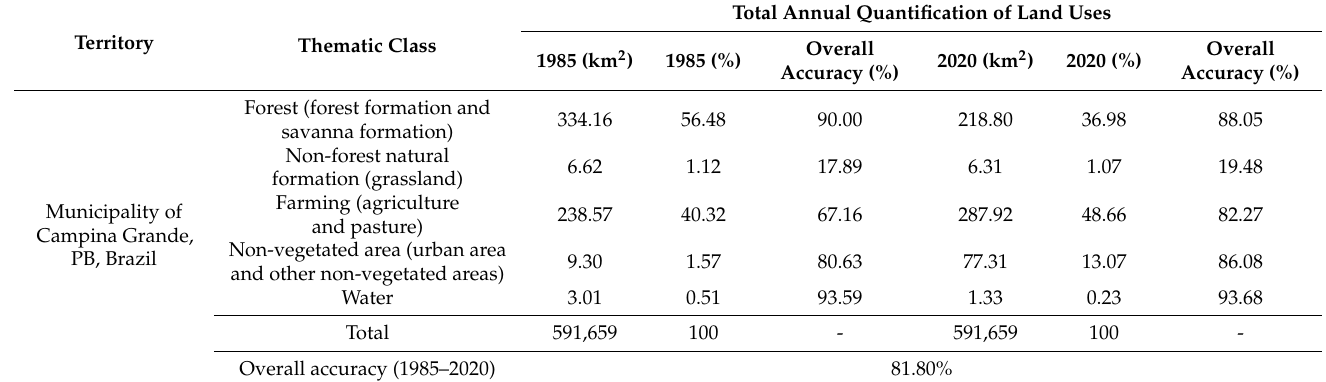
Table 1. Annual quantification of the different uses and land cover in the years of 1985 and 2020 for the semiarid region of Campina Grande − PB,